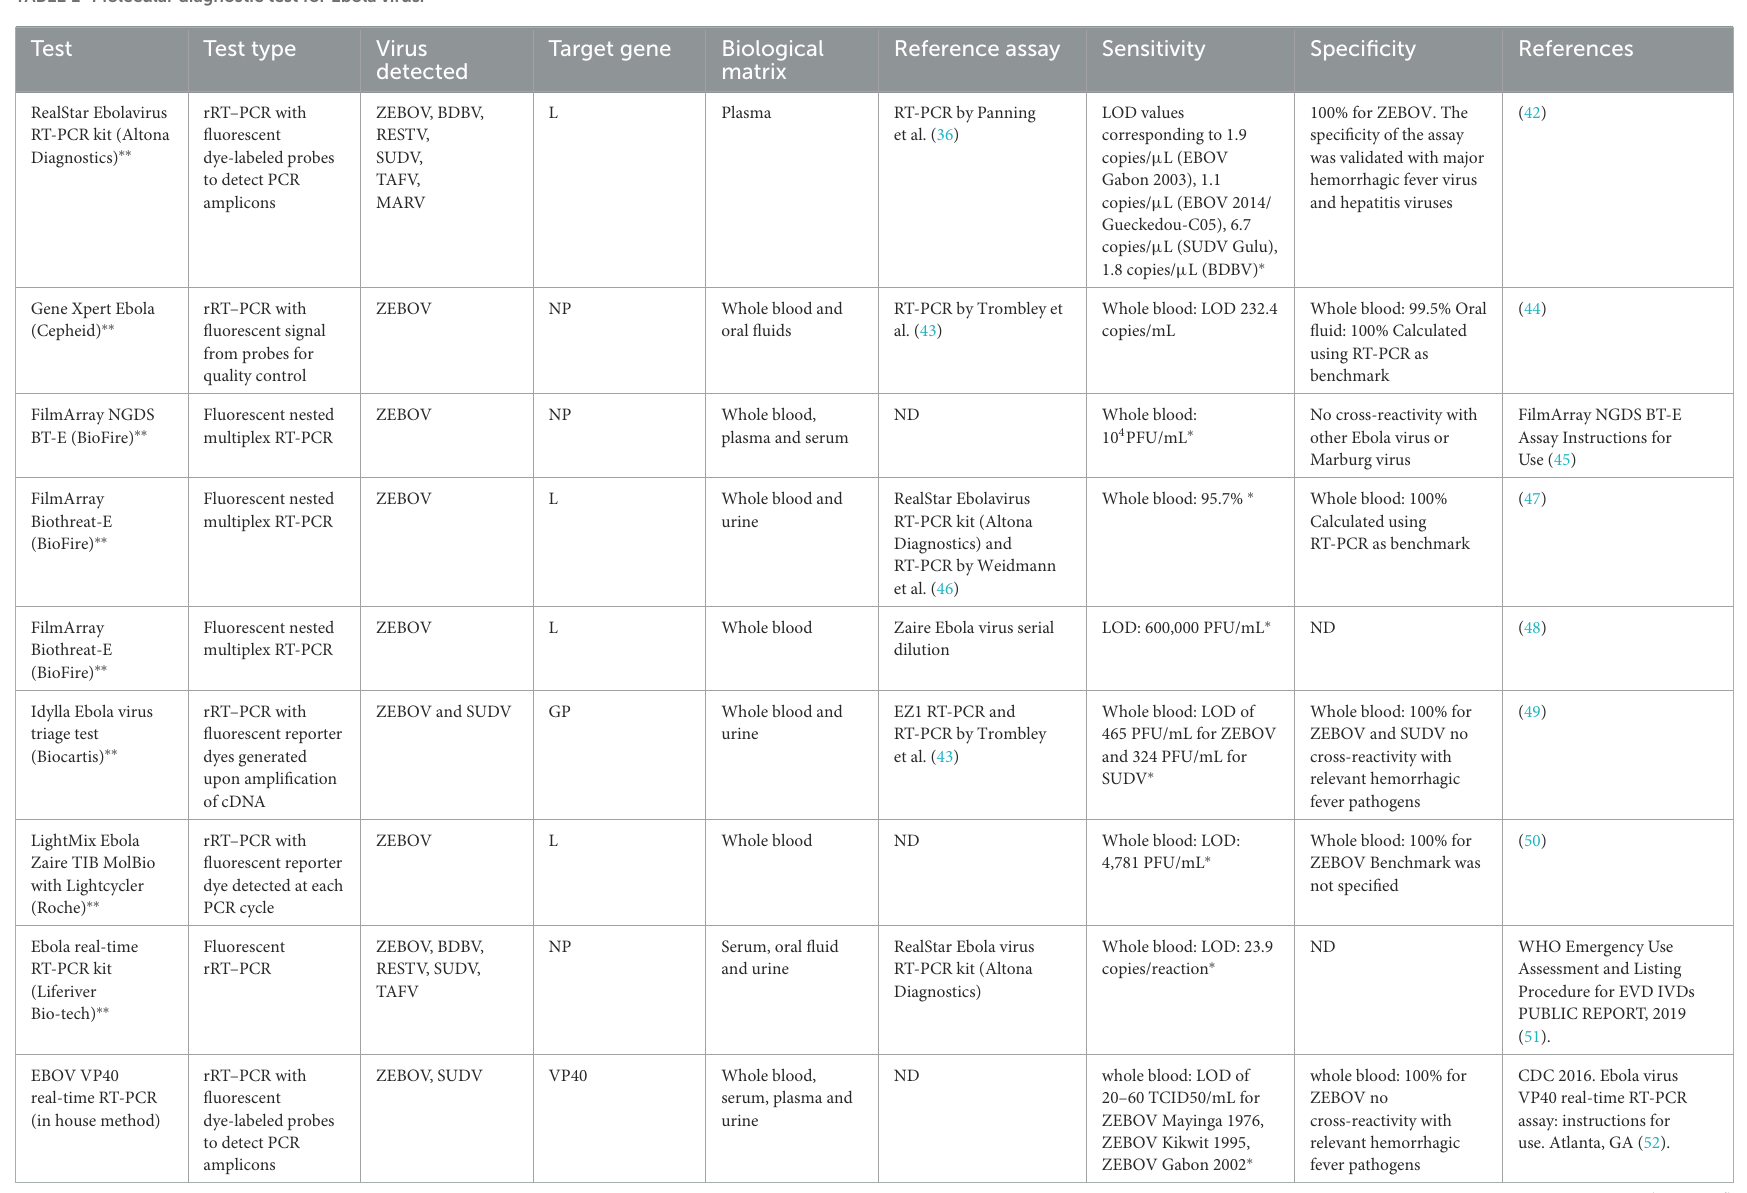
TABLE 1 Molecular diagnostic test for Ebola